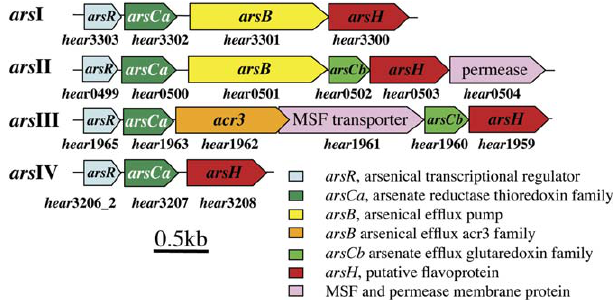
Figure 4. Organization of Arsenate-Resistance Operons (ars) in H. arsenicoxydans The three operons identified by complementation of an E. coli ars - deficient strain code for an ArsR regulator, one or two ArsC arsenate reductases, an As[III] extrusion pump, and an ArsH putative flavoprotein. The fourth operon present in the genome lacks the As[III] pump- encoding gene. doi:10.1371/journal.pgen.0030053.g004 PLoS Genetics |